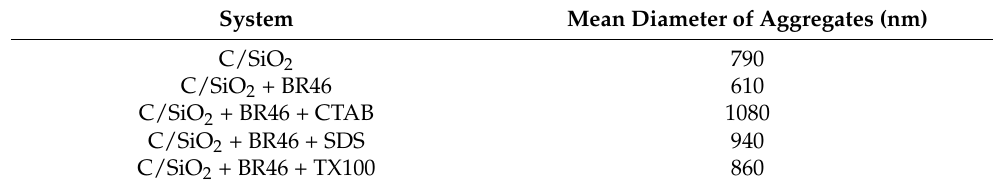
Table 4. The size of C/SiO 2 aggregates formed in the solutions without and with dye and surfactants.